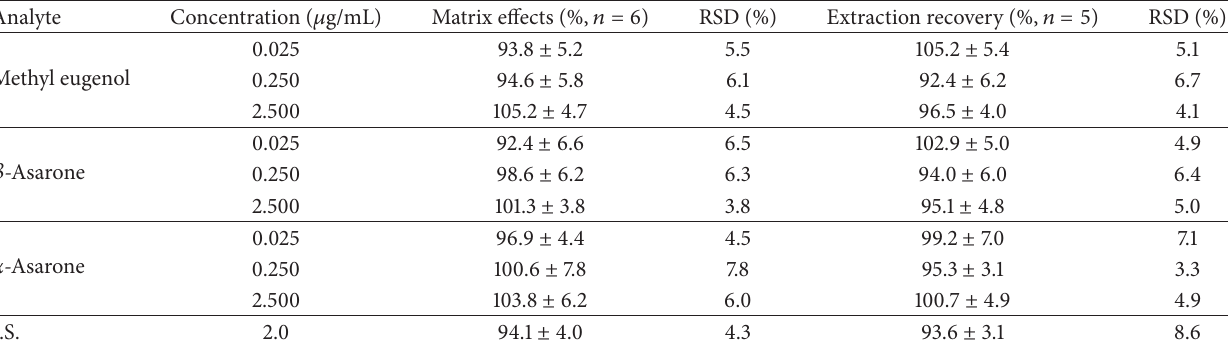
Table 3: Matrix effects and extraction recovery of analytes in biological samples.